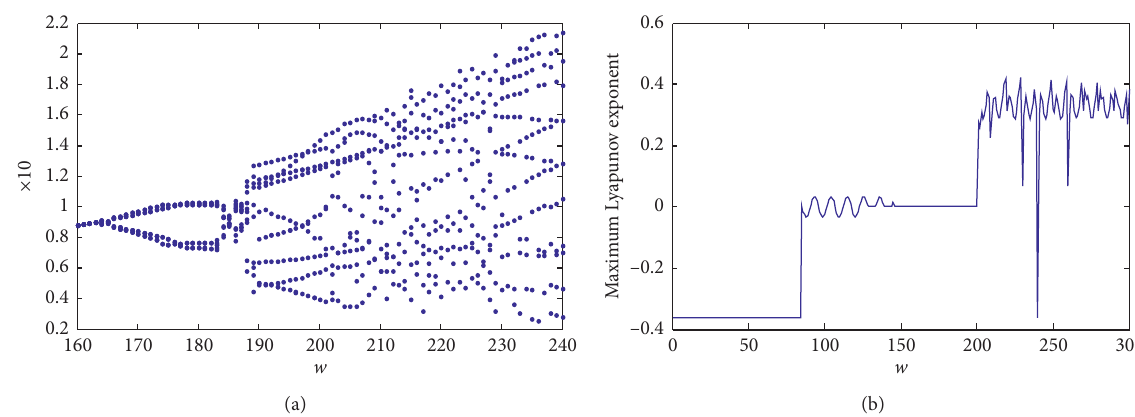
Figure 32: (a) Vibrational bifurcation diagram with the smoothed Coulomb model when t ∈ 0 . 05 0 . 0597 􏼂 􏼃 . (b) Maximum Lyapunov exponent curve with the smoothed Coulomb model when t ∈ 0 . 05 0 . 0597 􏼂 􏼃